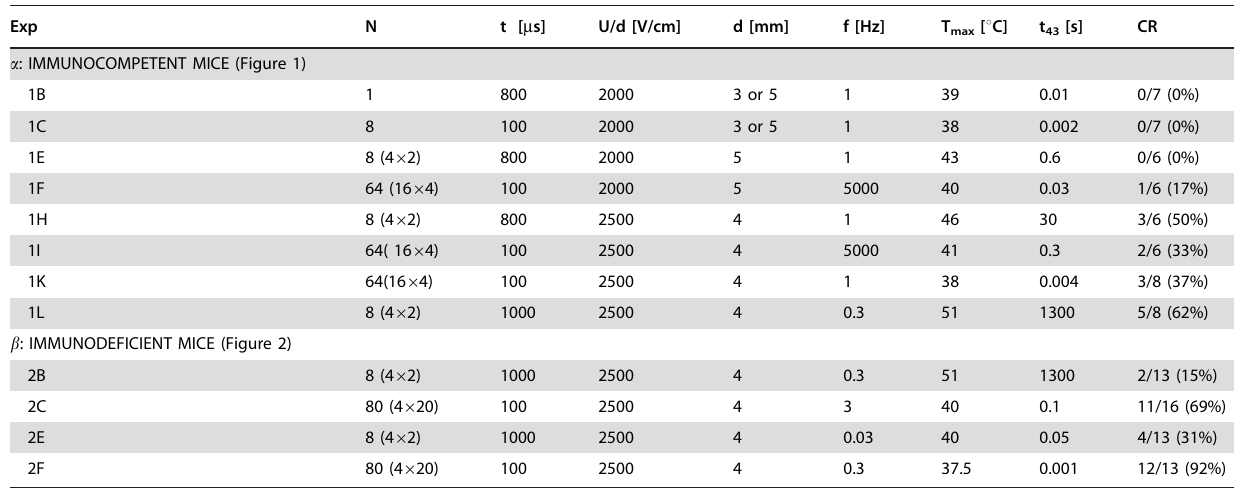
Table 1. Details of the experimental conditions tested and summary of the antitumor effects achieved. .. ... .... ... ... .... ... ... .... ... ... .... ... ... .... ... ... .... ... ... .... ... ... .... ... ... .... ... ... .... ... ... .... ... ... .... ... ... .... ... ... .... ... ... .